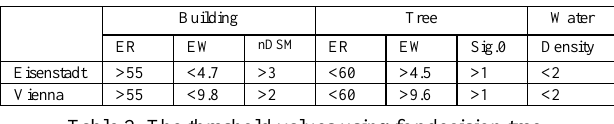
Table 2. The threshold values using for decision tree classification of buildings, trees and water body region for Eisenstadt and Vienna.